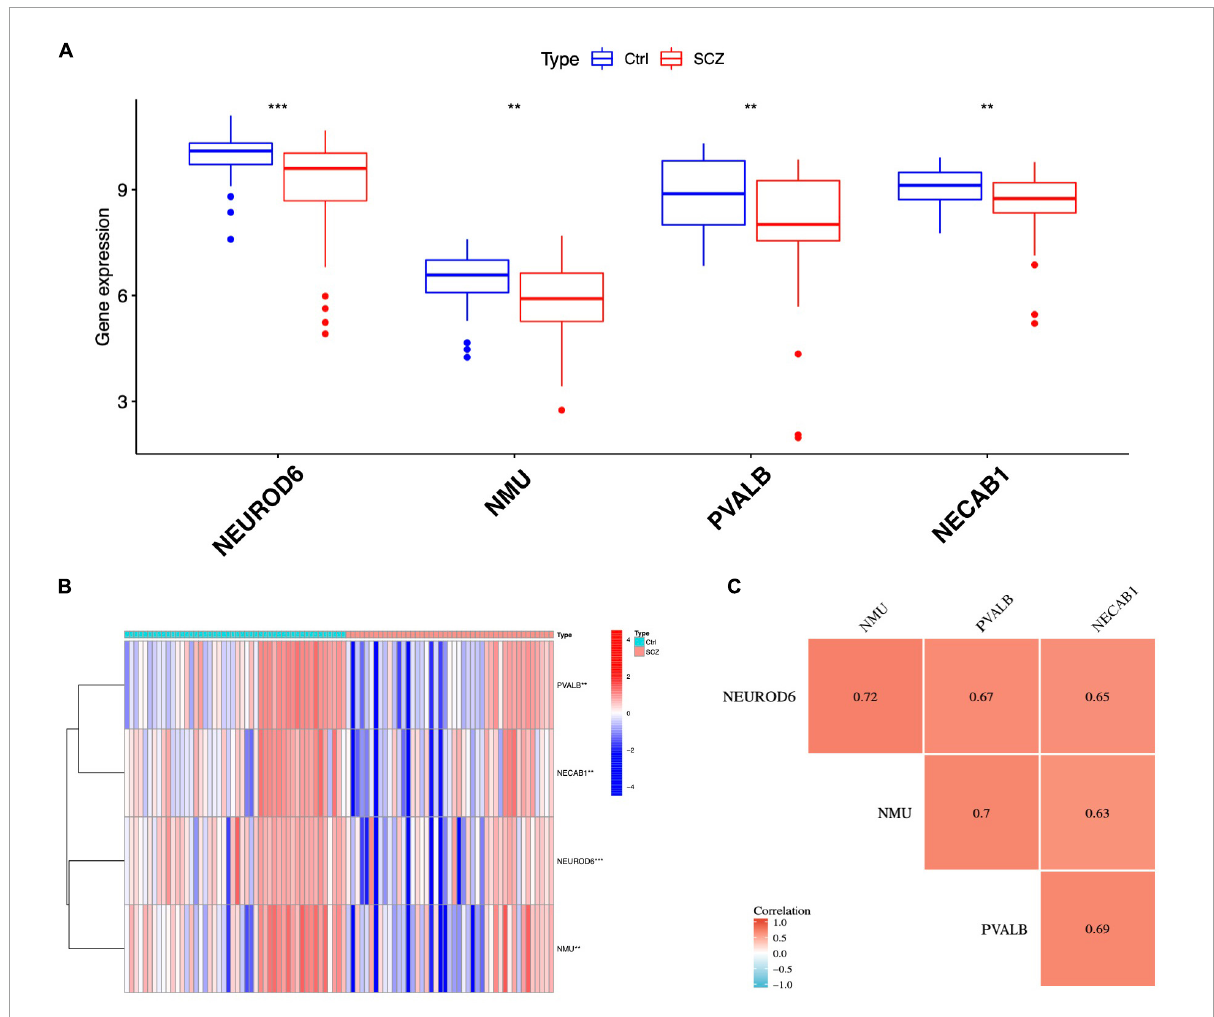
FIGURE7 Expression analysis of hub genes. (A) Expression of four hub genes in SCZ and control groups. (B) Heatmap of hub gene expression. (C) Correlation between hub genes. ** P < 0.01, *** P < 0.001 vs.